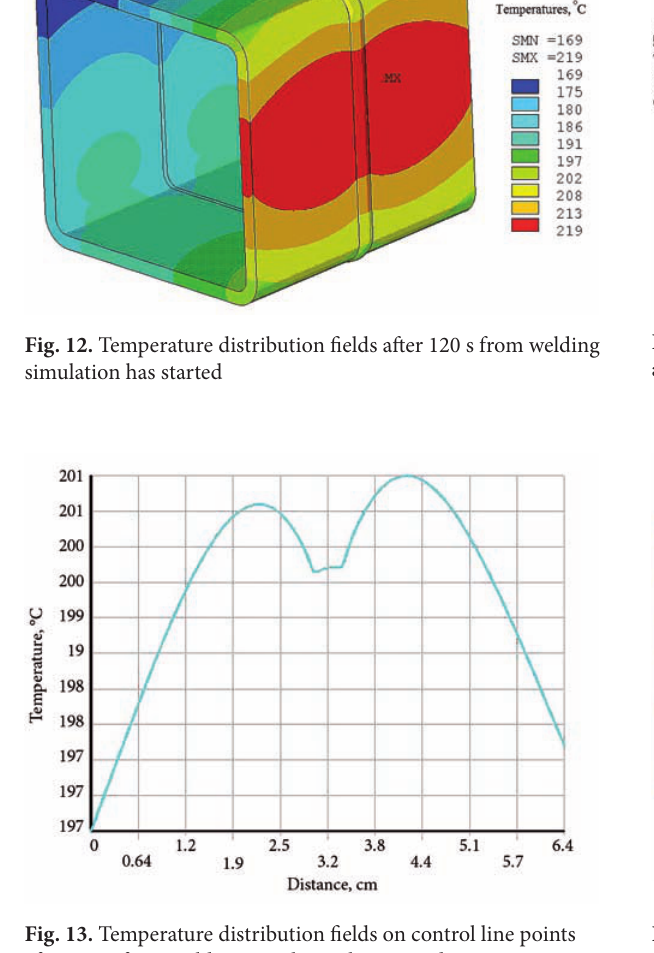
Fig. 13. Temperature distribution fields on control line points after 120 s from welding simulation has started